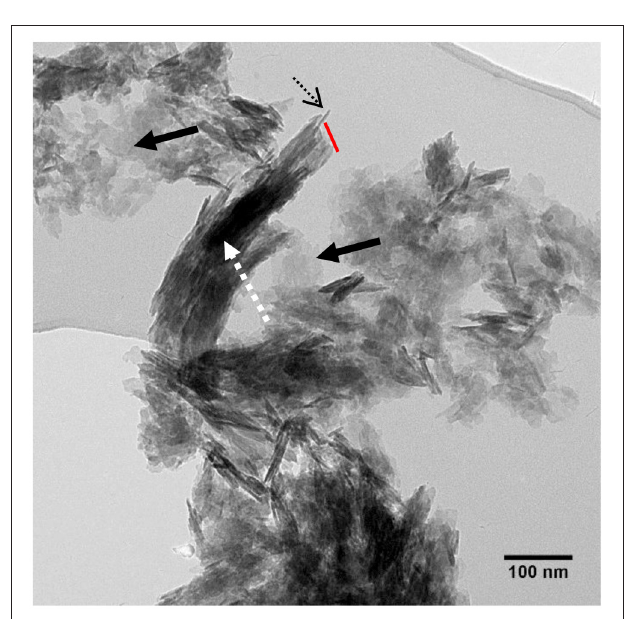
FIGURE 5 | TEM view of stacks of mineral lamellae extracted from deproteinized bovine bone mounted on carbon grid: dashed arrow, stack of about 15 mineral lamellae; dotted black arrow, edgewise view of single ML in stack; red line, broken end of stack cutting across all MLs. Solid black arrows: single MLs lying flat on carbon grid. From Valente and Schwarcz, unpublished